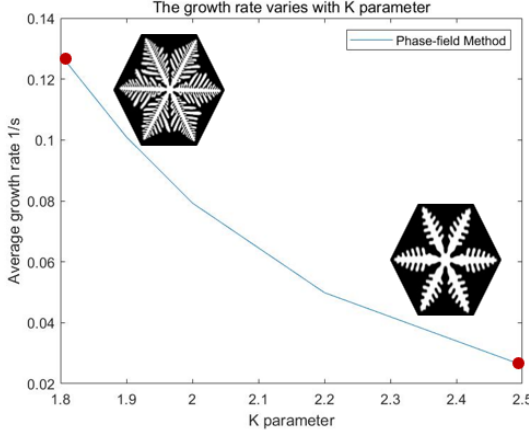
Figure 17. The growth rate varies with the K parameter by PF.